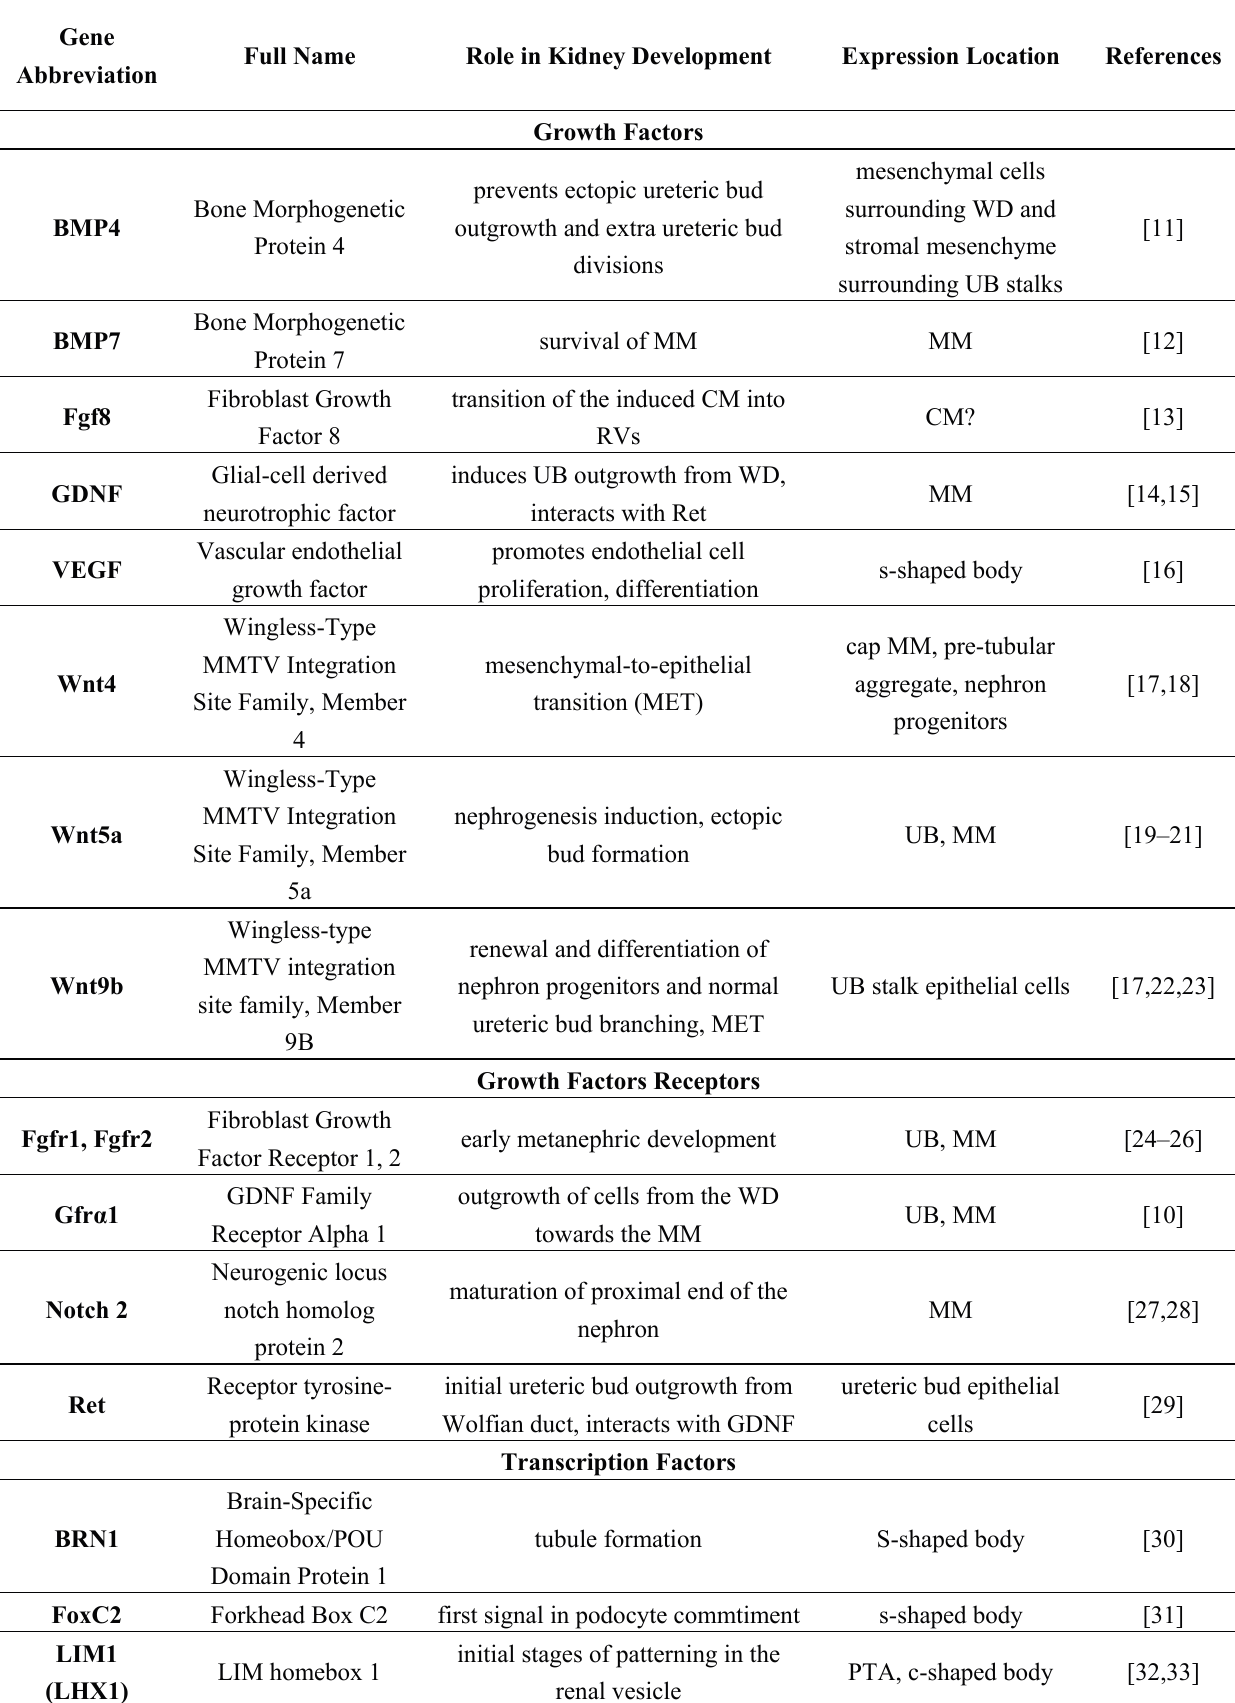
Table 1. Genes important for